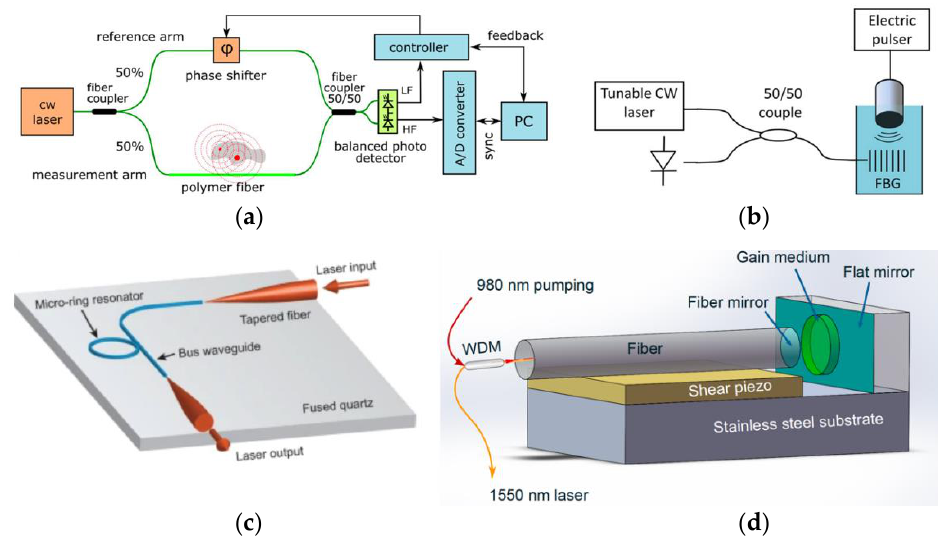
Figure 22. Schematic of optical ultrasound detectors. ( a ) Mach-Zehnder Interferometer. ( b ) Fiber Bragg grating. ( c ) Micro-ring Resonator. ( d ) Fabry-Pérot. Reproduced with permission from [91,173 – 175].